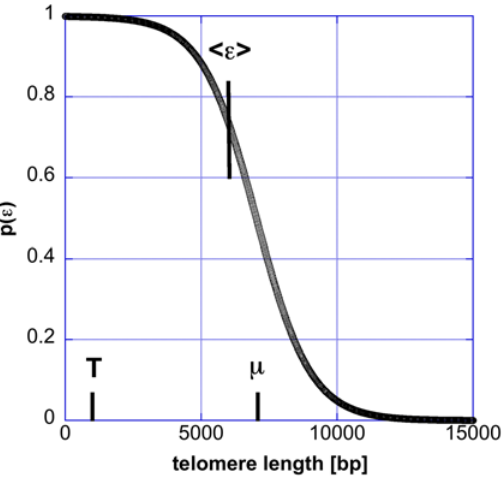
Figure 2. The feedback control function, maintaining the telomere length, is shown. On this figure the dependence of the probability (or the frequency), p , for occurrence of the open state on the telomere length e (in base pairs) is shown. The parameter m in this function is the telomere length at which the probability for the extending state is K . The parameter T=1000 determines the slope of the sigmoid. The choice of T is close to the maximum possible value for telomere homeostasis at telomere length of 6000 bp (see the text for an explanation).